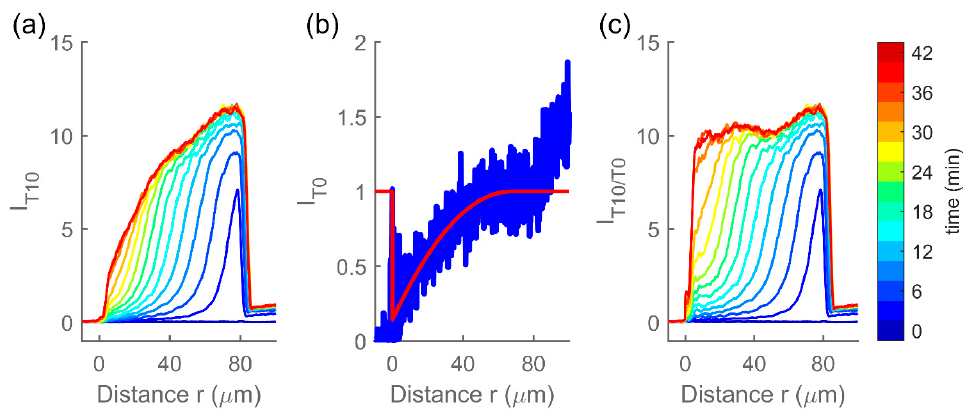
Figure 3. ( a ) an example of fluorescence profiles I T10 recorded by CLSM after addition of target MO-T10 to a MO hydrogel (angle-averaged, smoothed, and normalized to immersing solution being one). ( b ) the fluorescence intensity I T0 of the same hydrogel immersed in a nonbinding target MO-T0 in blue and a reference profiled obtained by a second-degree polynomial fit to I T0 shown in red. ( c ) fluorescence intensity profiles I T10 from ( a ) divided by the reference profiles form ( b ), to obtain the relative intensity profiles corrected for the effect of the presence of the fiber, i.e., relative concentration I T10/T0 . Fiber end face is located at r = 0 .